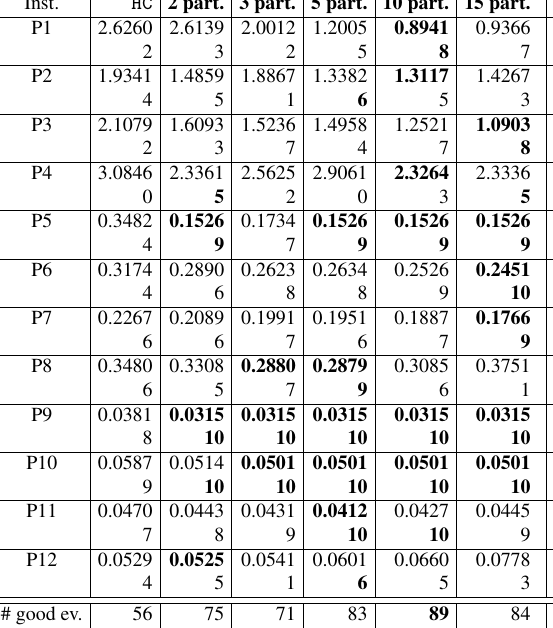
Table 8. Results obtained by PSO-ANSP with different number of particles.